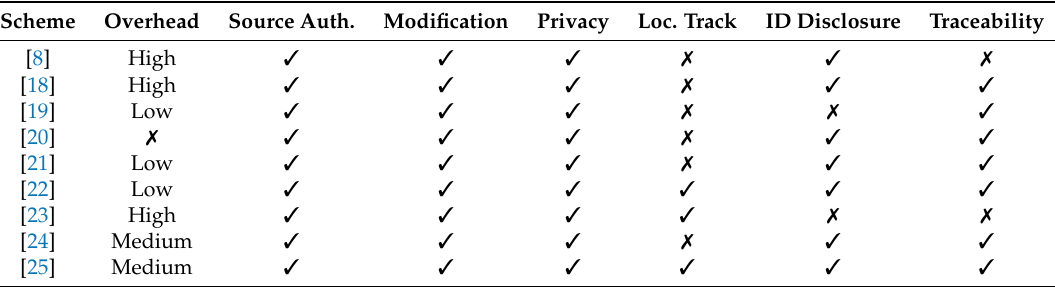
Table 1. Features of authentication-based schemes.